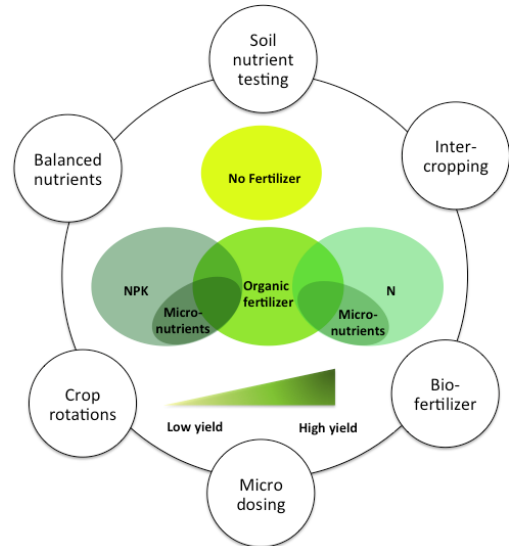
Figure 3. Nutrient management strategies that can be applied to maximize finger millet yield in farmers’ fields. The internal Venn diagram (green) demonstrates the effects of integrated nutrient management on finger millet yield. The outer ring represents other nutrient management options that can be incorporated. Finger millet yield can be maximized through application of balanced NPK, farmyard manure (FYM), and micronutrients together, compared to no fertilizer, N alone or farmyard manure